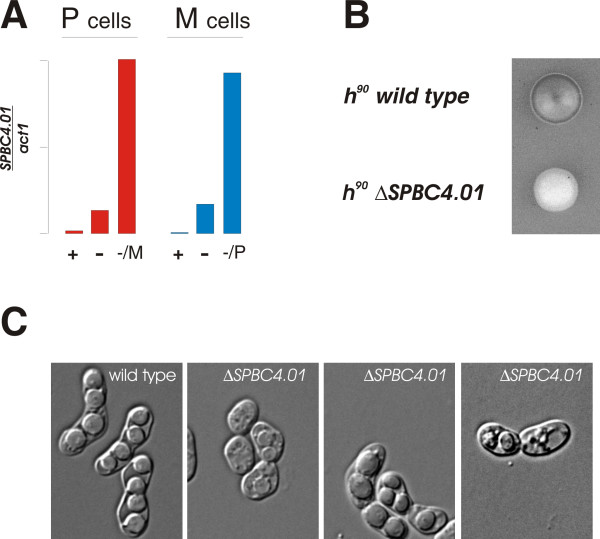
Analysis of the pheromone-induced gene SPBC4.01. A. Expression of SPBC4.01 in P cells (left half, red bars) and M cells (right half, blue bars). Cells were either growing in medium with nitrogen (+), without nitrogen (-), or without nitrogen in the presence of M factor (-/M) or P-factor (-/P). At the different growth conditions, the level of SPBC4.01 RNA was quantitated relative to act1 RNA by real time PCR. B. Sporulation defect of ΔSPBC4.01cells. The picture shows iodine staining of h90 wild type and h90 ΔSPBC4.01 colonies grown on the same MSA plate. C. Micrographs of h90 wild type and h90 ΔSPBC4.01 cells showing examples of abnormal mating and sporulation in the latter.